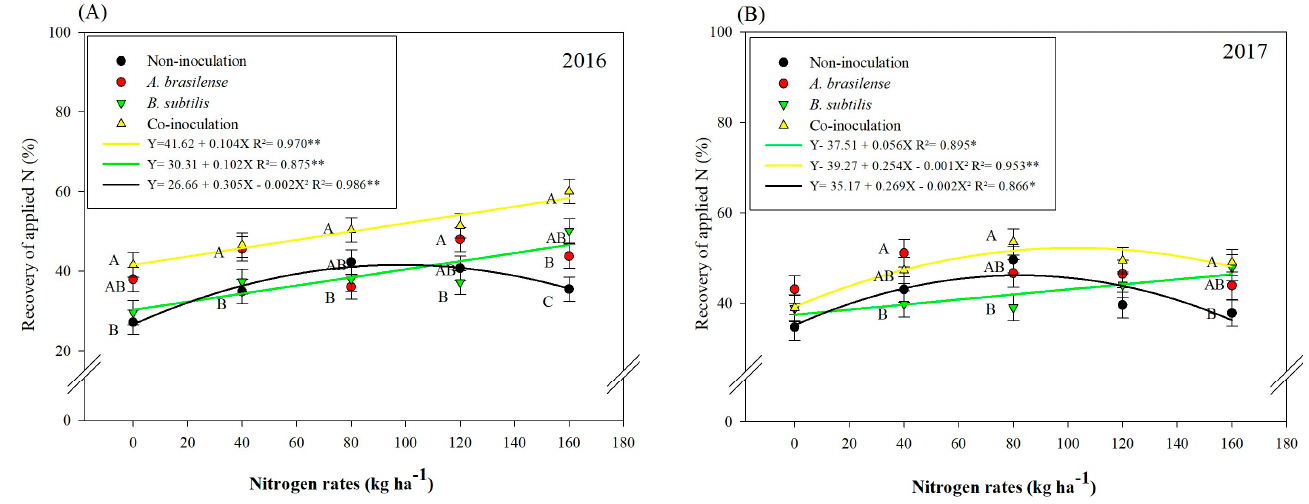
Figure 2. Recovery of applied N in 2016 ( A ) and 2017 ( B ) as a function of N doses and plant growth- promoting bacterial inoculations and co-inoculation. Error bars indicate standard deviation of the means ( n = 4 replications). * and **: means it is statistically significant by Tukey's test at probability p ≤ 0.05 and p ≤ 0.01, respectively. Table 3. Leaf chlorophyll index (LCI), plant height and number of tillers m − 1 of wheat as a function of plant growth-promoting bacteria and N doses in the 2016 and 2017 cropping